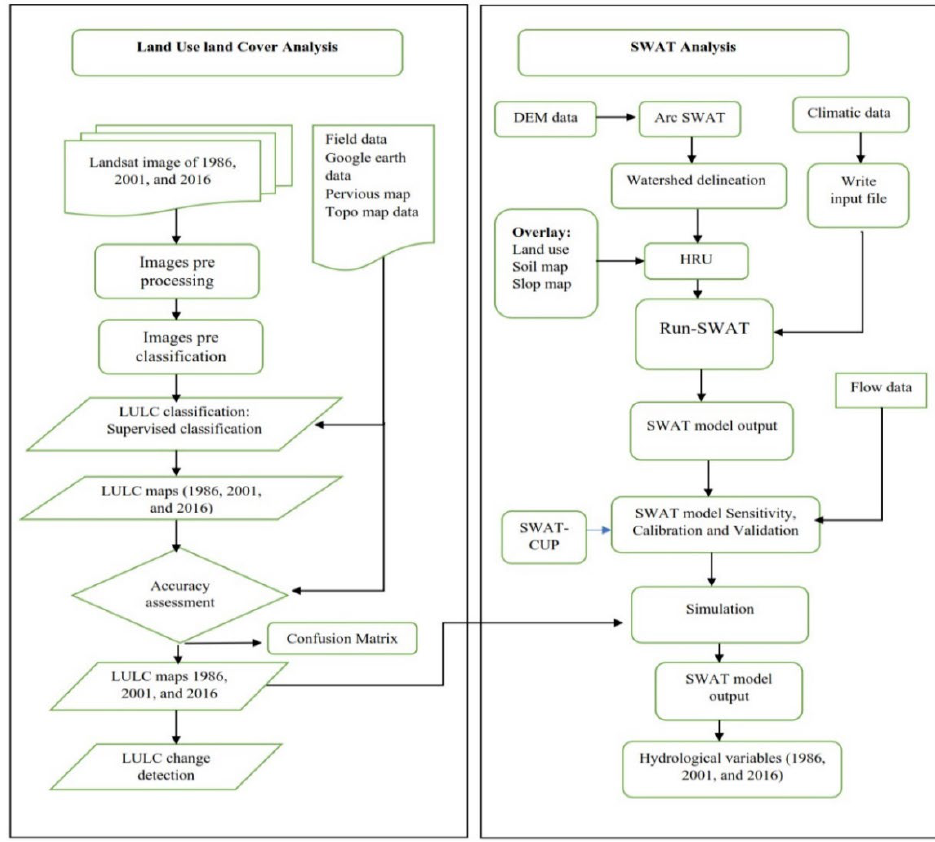
Figure 2. Conceptual framework of the research.